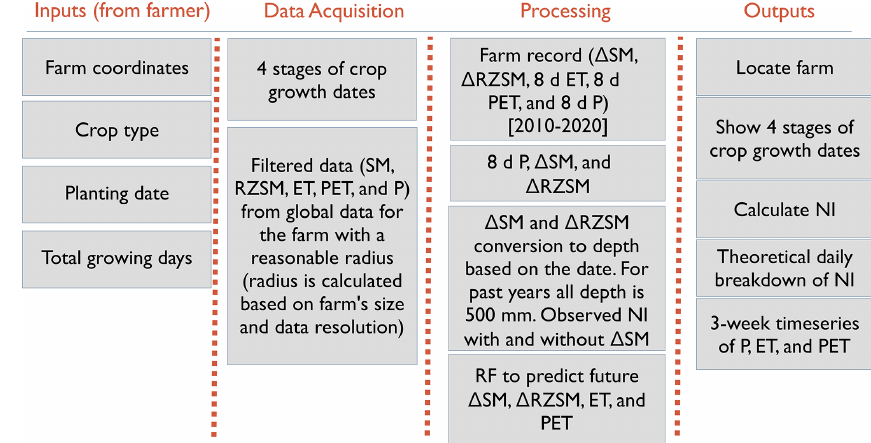
Figure 2. A chart description of the structure of FarmCan.